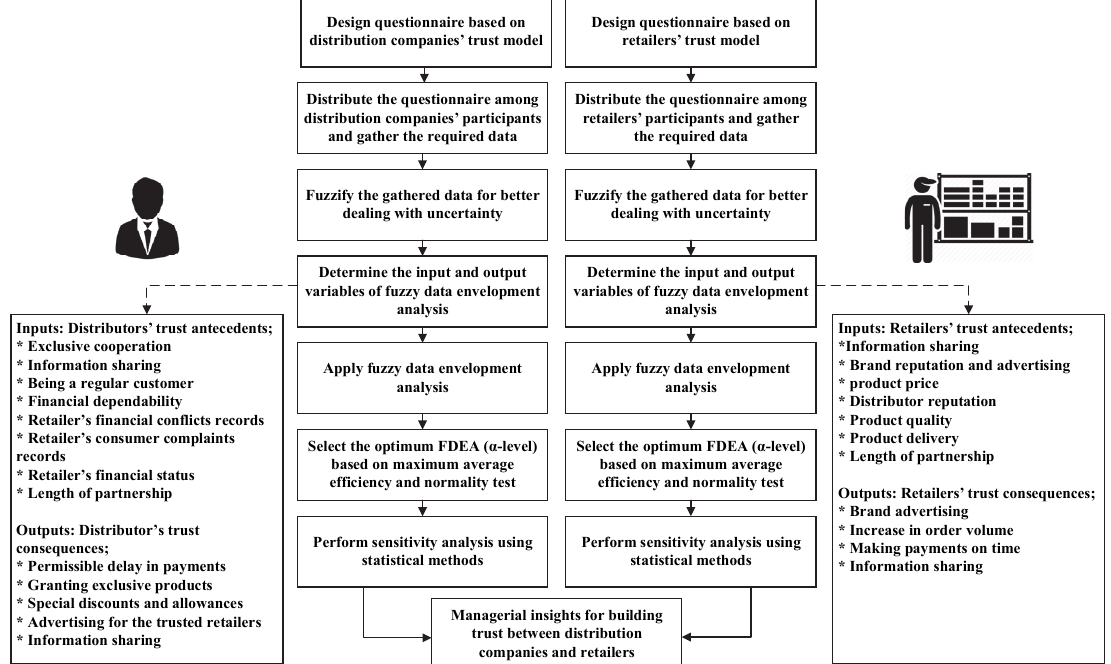
Fig. 3. The schematic view of the proposed